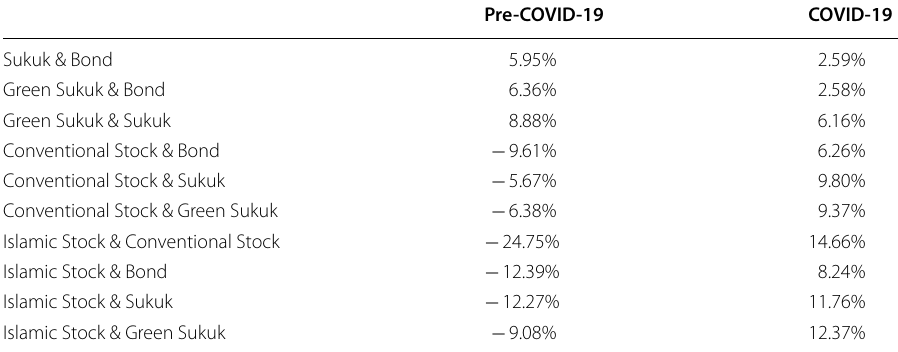
Table 5 Economic significance